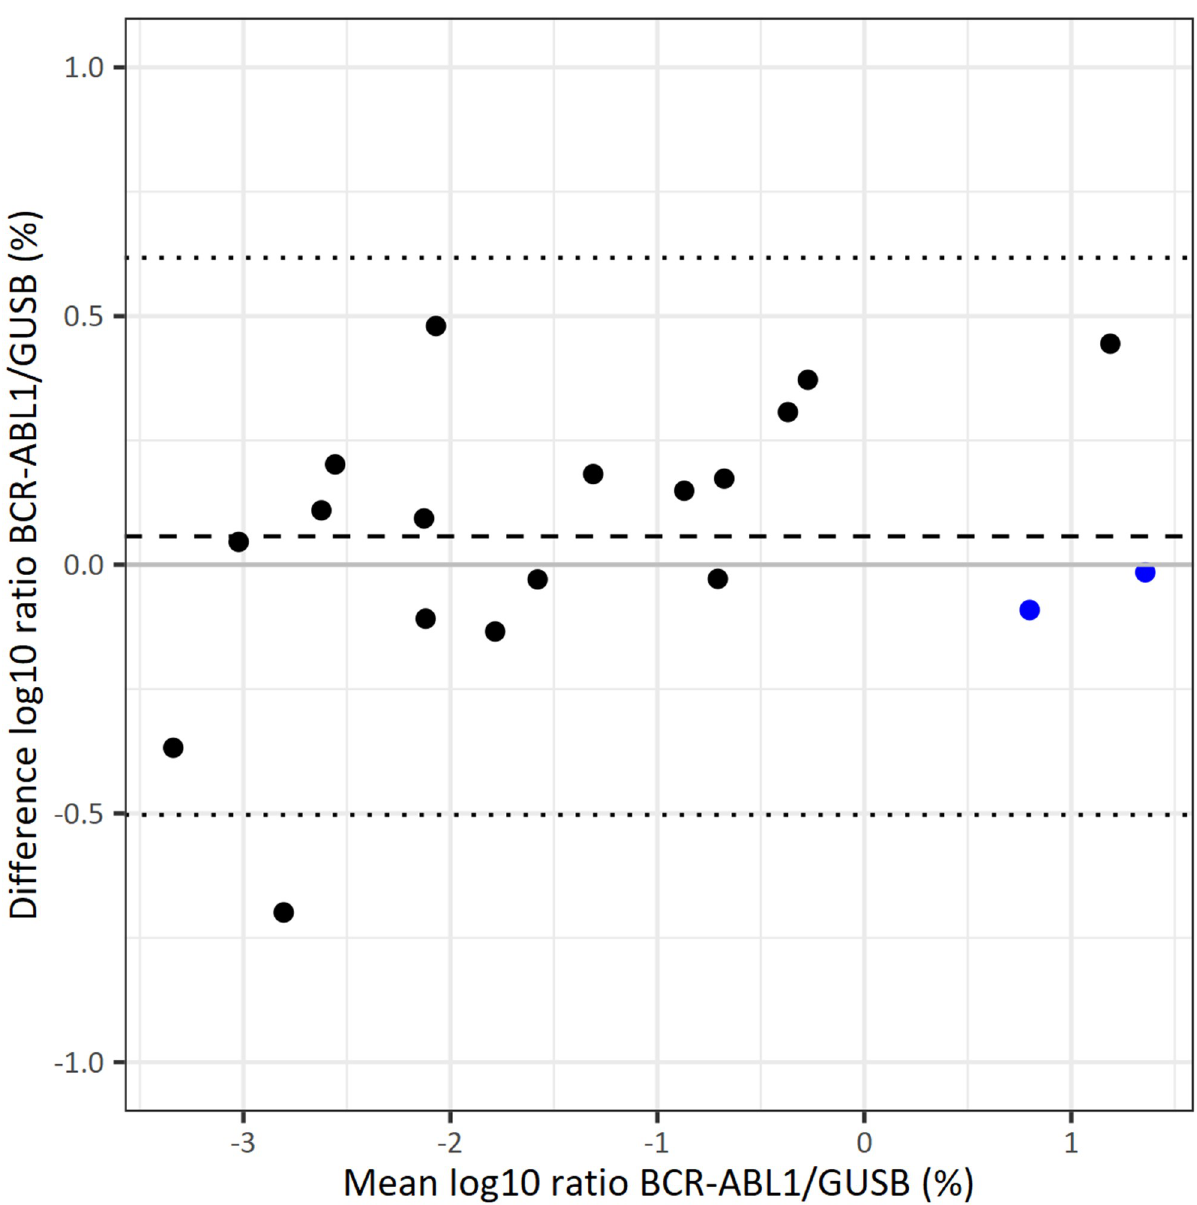
Fig 7. Bland Altman plot for data obtained with the reference and the new method. Black, Poisson analysis of digital PCR data for BCR-ABL1; blue, Ct-value analysis of quantitative real-time PCR for BCR-ABL1).